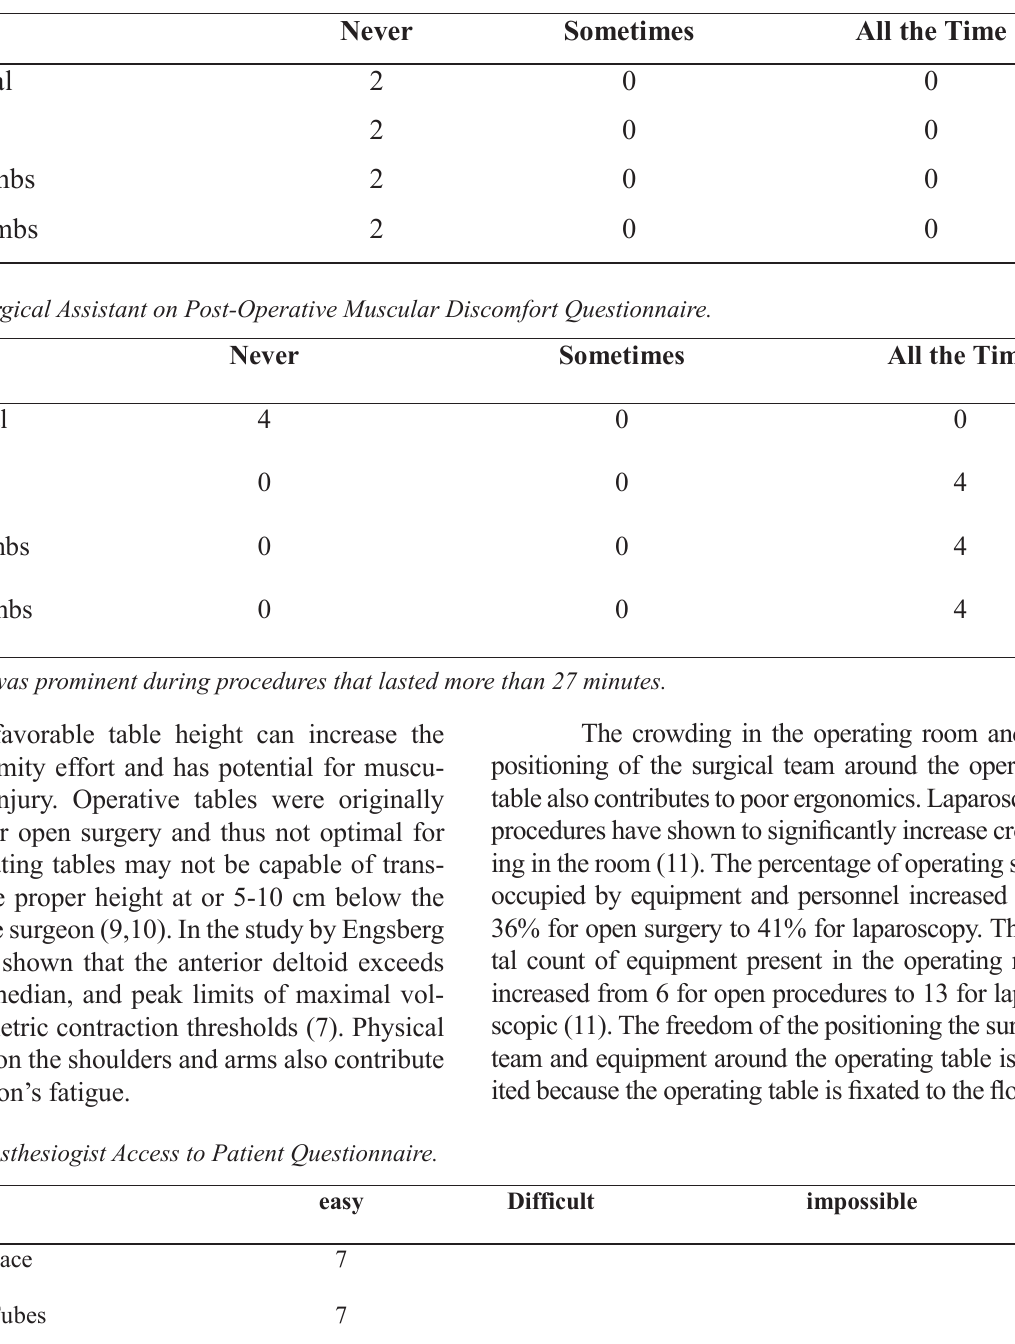
Table 4 - Surgeon Post-Operative Muscular Discomfort Questionnaire.